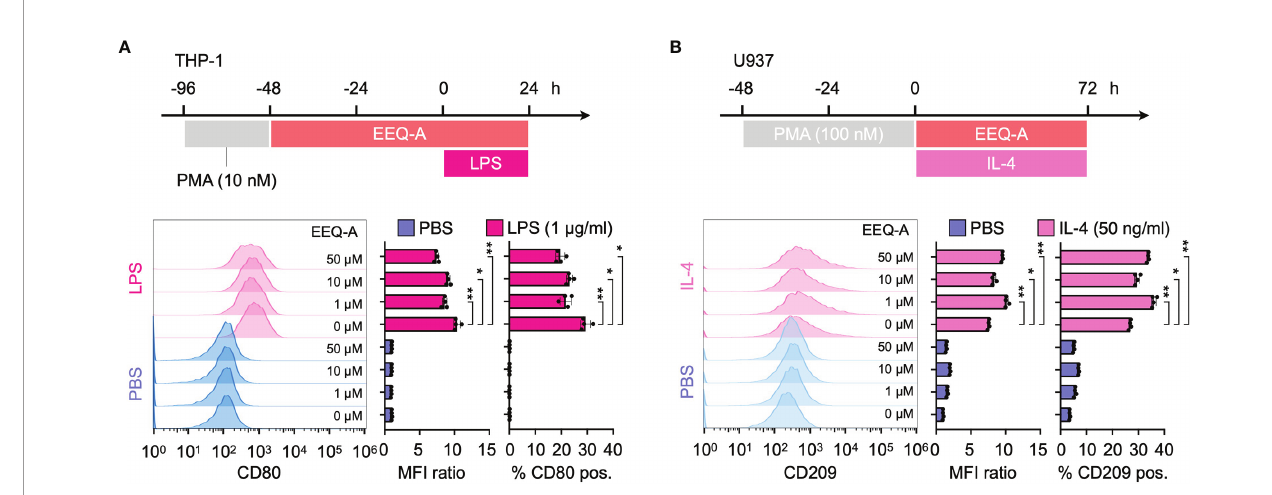
FIGURE 4 | (A) Polarization protocol to M1 macrophages by THP-1 cells. The histogram shows the MFI ratio of FITC for anti-human CD80 antibodies and the percentage of M1 macrophages. (B) The polarization protocol to M2 macrophages by U937 cells. The histogram shows the MFI ratio of Alexa Fluor 647 for anti- human CD209 antibodies and the percentage of M2 macrophages. **: < 0.0001, *: 0.0001 to 0.05. All experiments were triplicated.